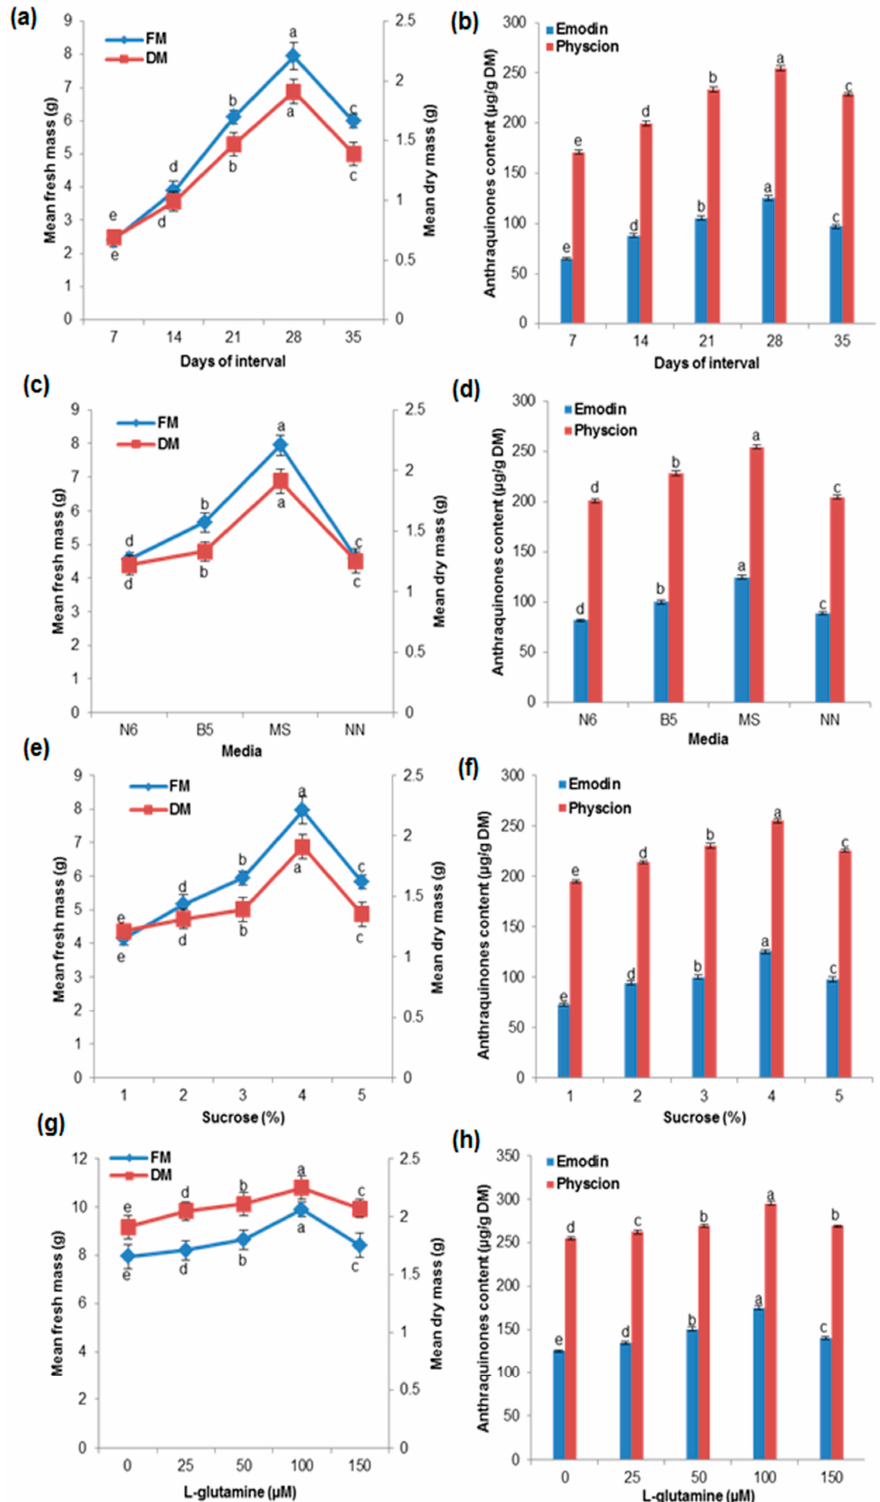
Figure 2. Effects of various media and concentration of sucrose, L -glutamine and growth kinetics of biomass accumulation and anthraquinone (emodin and physcion) production in cell suspension cultures of P. multiflorum : ( a , b ) Growth kinetics; ( c , d ) media; ( e , f ) sucrose; ( g , h ) L -glutamine. Means ± standard deviation of three replicates followed by the same letters are not significantly different according to DMRT at p ≤ 0.05.